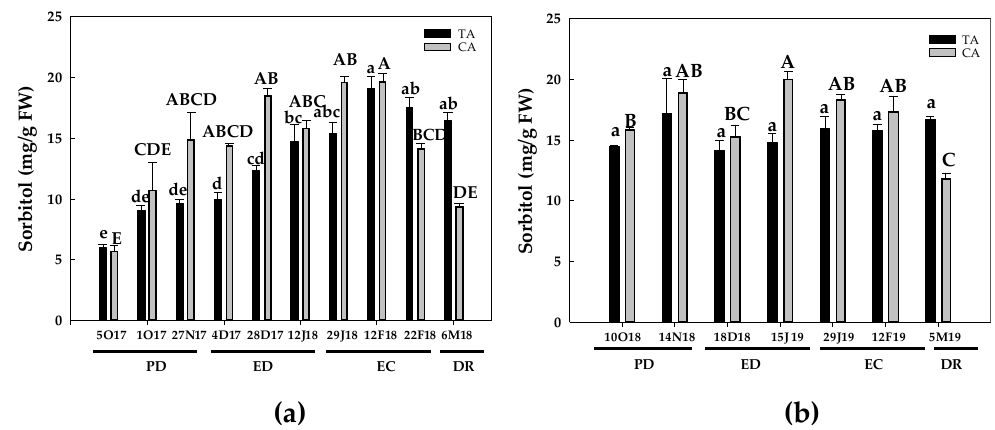
Figure 6. Evolution of sorbitol contents in flower buds of peach ‘GEM020’ cultivated in two different geographical areas during the dormancy cycle on two seasons. ( a ): season 1 (2017–2018); ( b ): season 2 (2018–2019). Data represent the mean ± SE, n = 5. Different letters (lowercase and uppercase for the samples of the temperate (TA) and the cold area (CA), respectively) indicate significant differences according to Tukey’s multiple test ( p ≤ 0.05). PD: paradormancy; ED: endodormancy; EC: ecodormancy; DR: dormancy release. FW: fresh weight. The chill units accumulated at the different times and locations are shown in Supplemental file